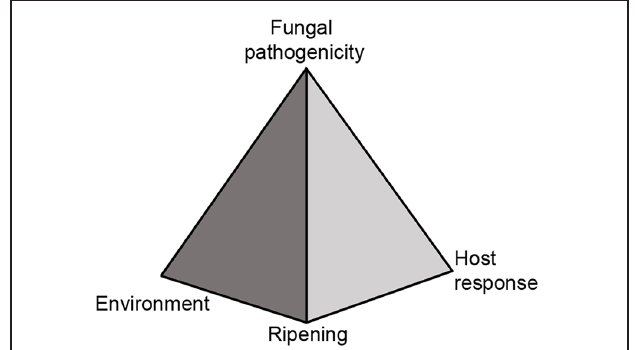
FIGURE 1 | Disease pyramid of post-harvest fruits and pathogenic fungi interaction. The disease of post-harvest fruits and pathogenic fungi is regulated by four elements: (1) Fungal pathogenicity, (2) host response, (3) environment, and (4) ripening or